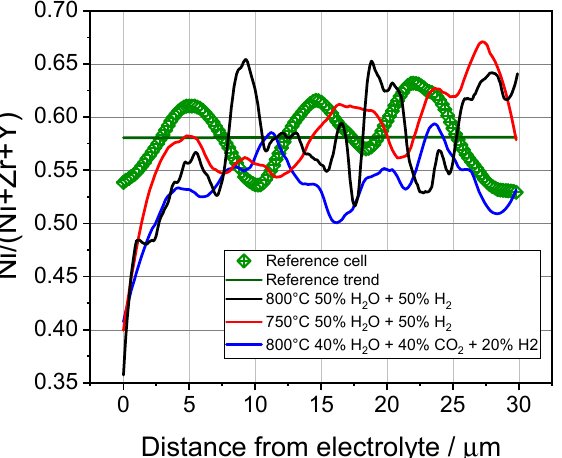
Figure 11. Comparison of Ni/(Zr + Y + Ni) (atomic ratio) mean value of the fuel electrode per cell to the distance from the YSZ electrolyte. The EDX results were measured close to the electrode/electrolyte interface (average of results computed on 30 × 4 µm 2 areas).